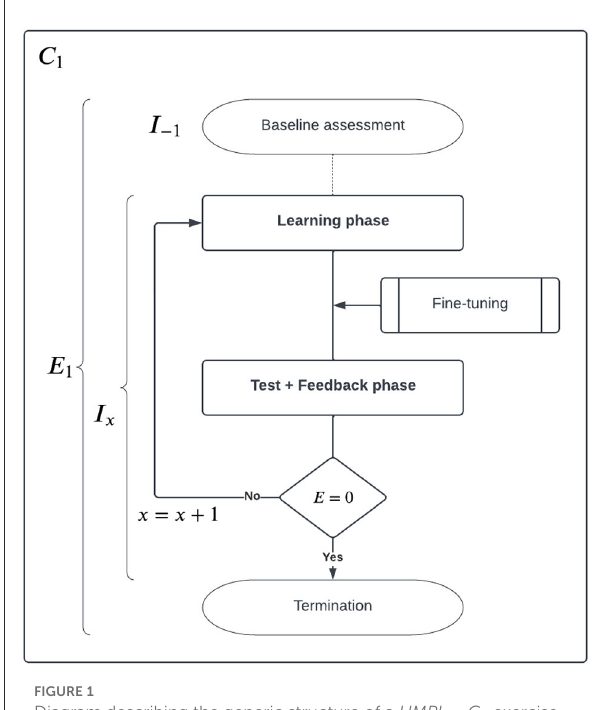
FIGURE1 Diagram describing the generic structure of a HMPL − C 1 exercise. The curriculum is composed of exercises which are composed of iterations containing learning and testing phases. Within this article, we describe only the most simple case with one single iteration (e.g., x <